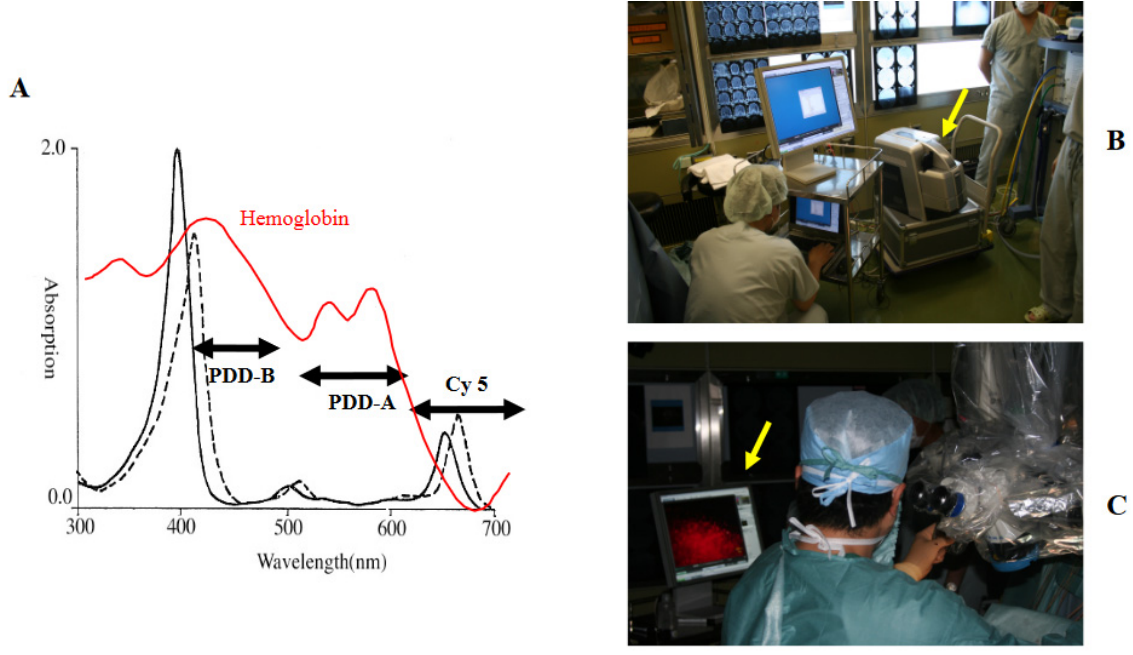
Figure 1. Absorption spectrum of TPS and filter systems. ( A ): Absorption spectrum of TPS and hemoglobin. (solid line: TPS and phosphate buffer solution; dotted line: TPS conjugated with albumin; red line: hemoglobin). Three filter systems were used to observe the fluorescence emitted from the obtained tissues. (PDD-B: excitation 450/40 nm, absorption 460 nm; PDD-A: excitation 550/40 nm, absorption 610 nm; Cy 5: excitation 620/60 nm, absorption 700/75 nm). ( B ): A compact fluorescence microscope (yellow arrow) placed in the operating theater. ( C ): Fluorescence images obtained under each filter system were displayed on the PC monitor (yellow arrow), and the surgeon was able to detect the presence of the tumor cells emitting fluorescence.